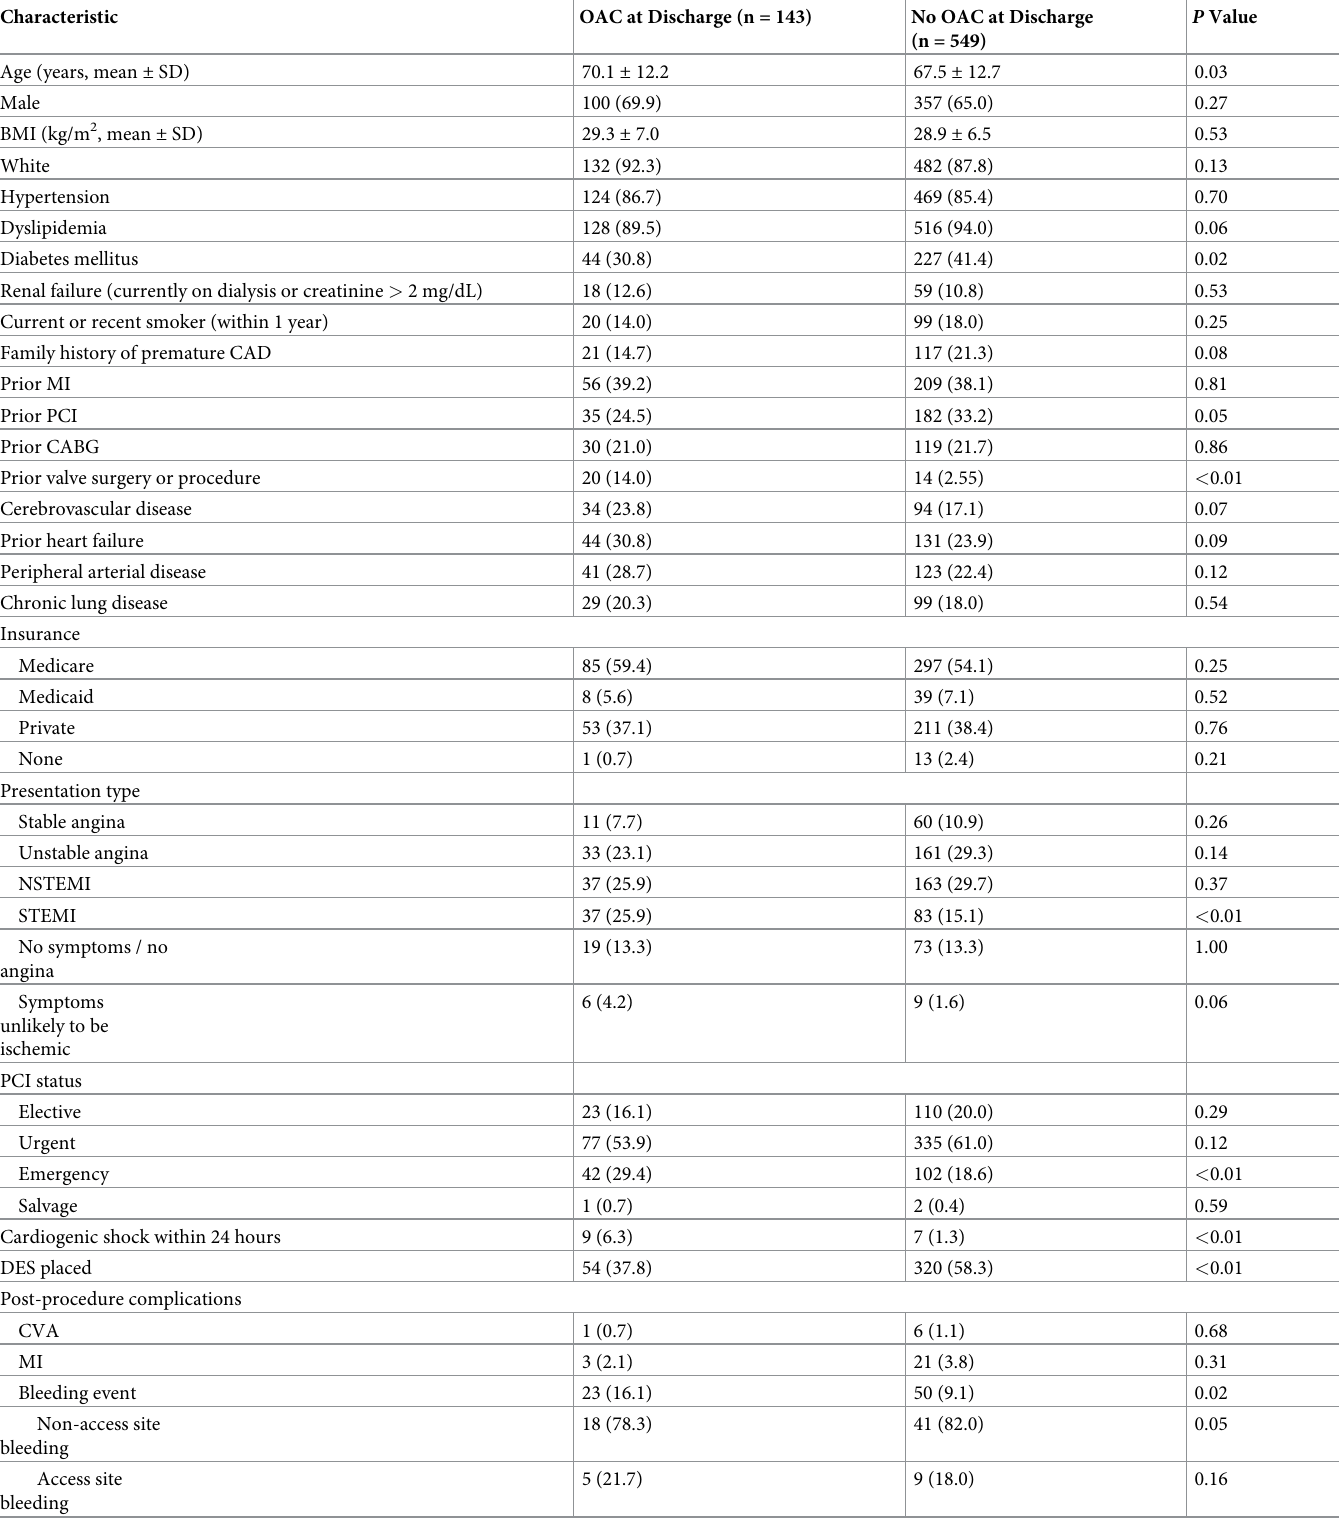
Table 2. Baseline and procedural characteristics of patients readmitted within 30 days after percutaneous coronary intervention (PCI).